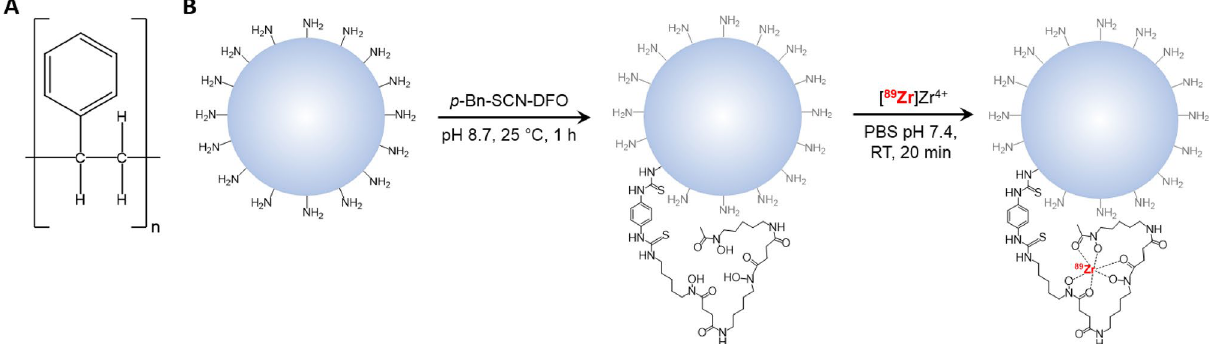
Figure 1. ( A ) The structure of polystyrene (PS). ( B ) The modification of an amine-functionalized PS particle with desferrioxamine (DFO) and its subsequent radiolabeling with [ 89 Zr]Zr 4+ to yield [ 89